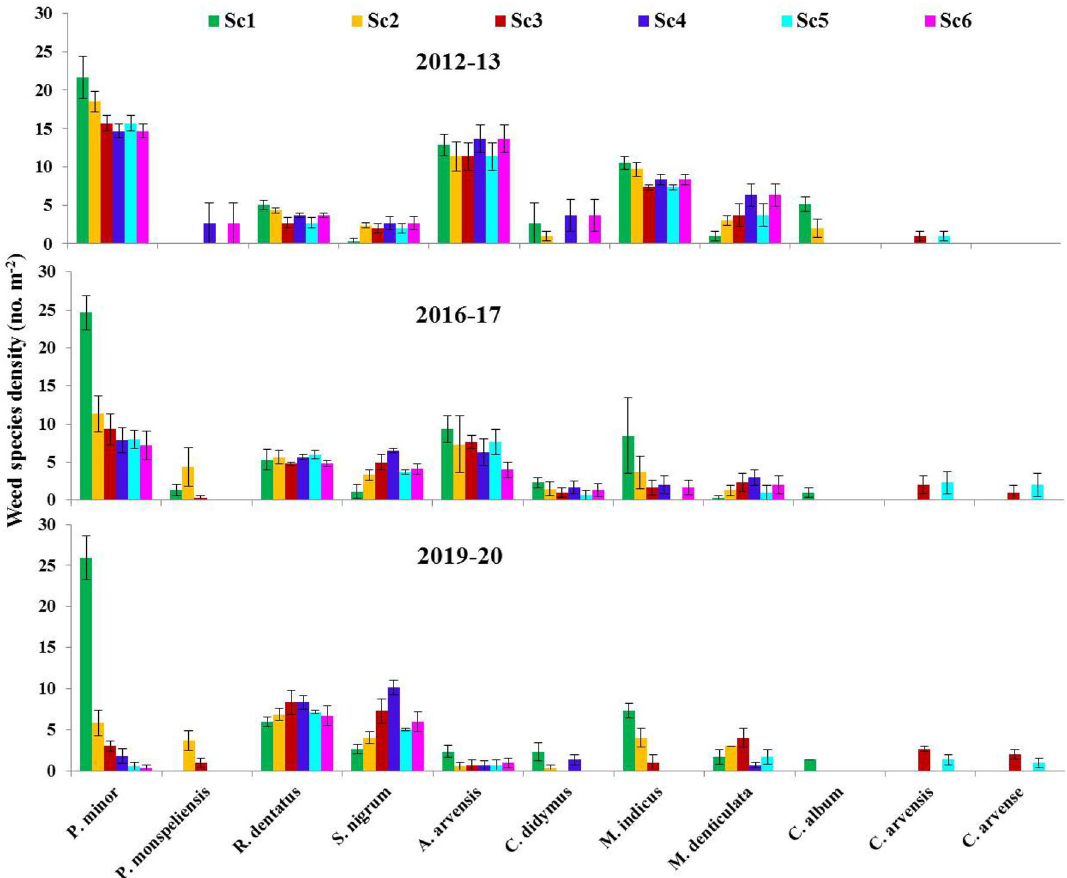
Figure 2. Effects of climate-smart agriculture-based management practices on major weed species density (no. m −2 ) at 45 days after planting during different years. Vertical bars indicate ± SE of mean. Sc1 conventional